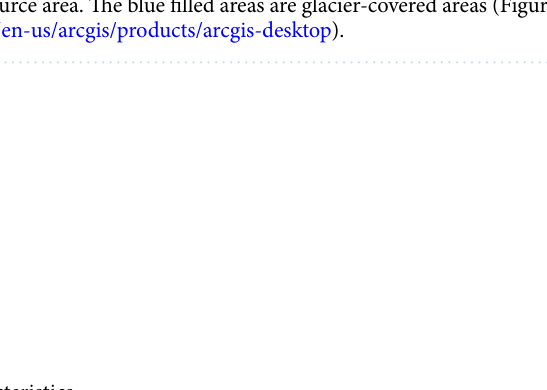
Table 2. Landslide inventory summary characteristics.